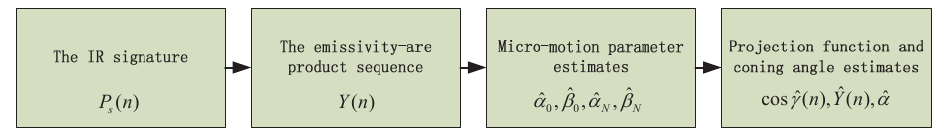
Figure 5. Process flow of the estimation